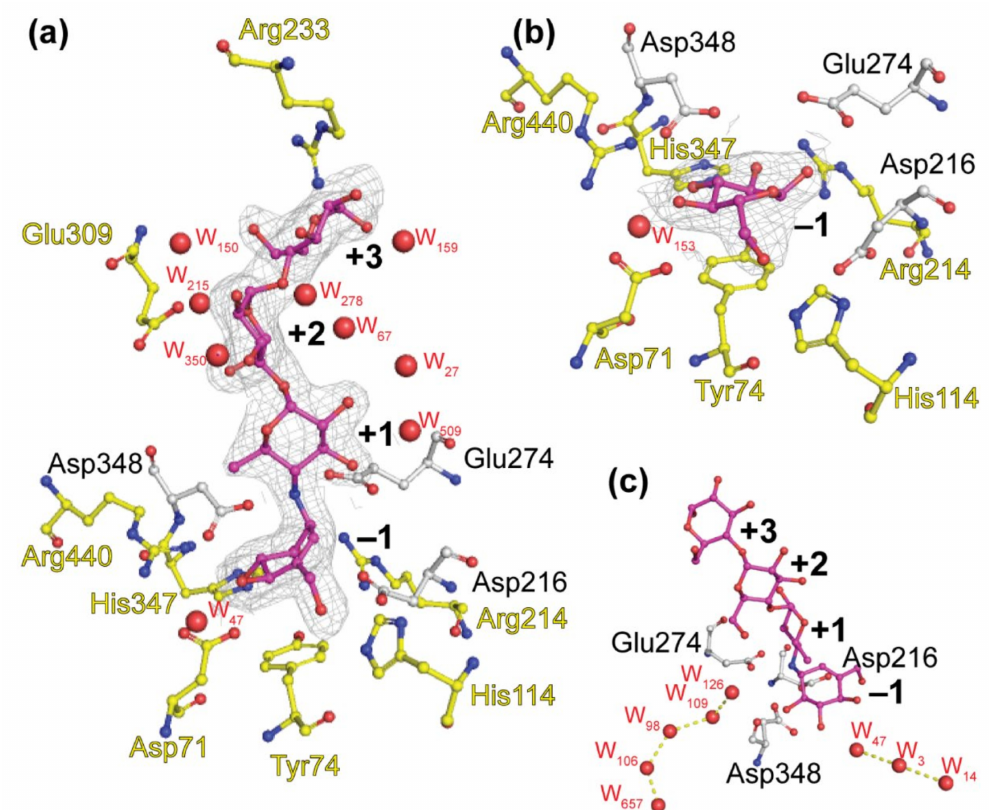
Figure 4. Binding of α -acarbose ( a ) and D-glucose ( b ) to the active center of the maltase Ba AG2. Water chains reaching the active center on Ba AG2-acarbose structure are shown on panel ( c ). Catalytic triad (Asp216, Glu274, and Asp348) residues are in grey, amino acids contributing to ligand binding are shown in yellow, and water molecules (W) are shown as red spheres. Acarbose and glucose are colored in magenta and final 2Fo-Fc electron density contoured at 1 σ . Binding subsites of acarbose are designated with bold numbers. Structures were visualized with PyMol